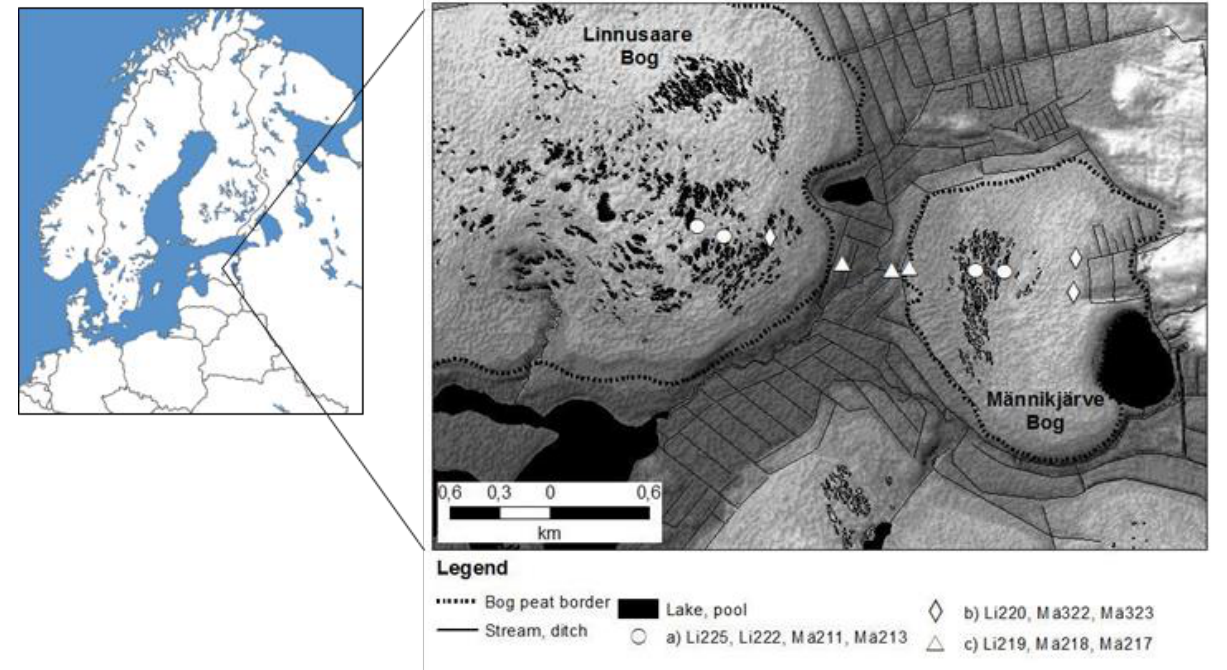
Figure 1. Location of study sites on the digital elevation model of Linnusaare (Li) and Männikjärve (Mä) Bogs (central-east Estonia). The legend lists groundwater (GW) well numbers from west to east. The GW wells are grouped by ecotope type: a) ridge-pool, b) ridge-hollow, c) forested/treed. The digital elevation model was created from LiDAR data scanned by the Estonian Land